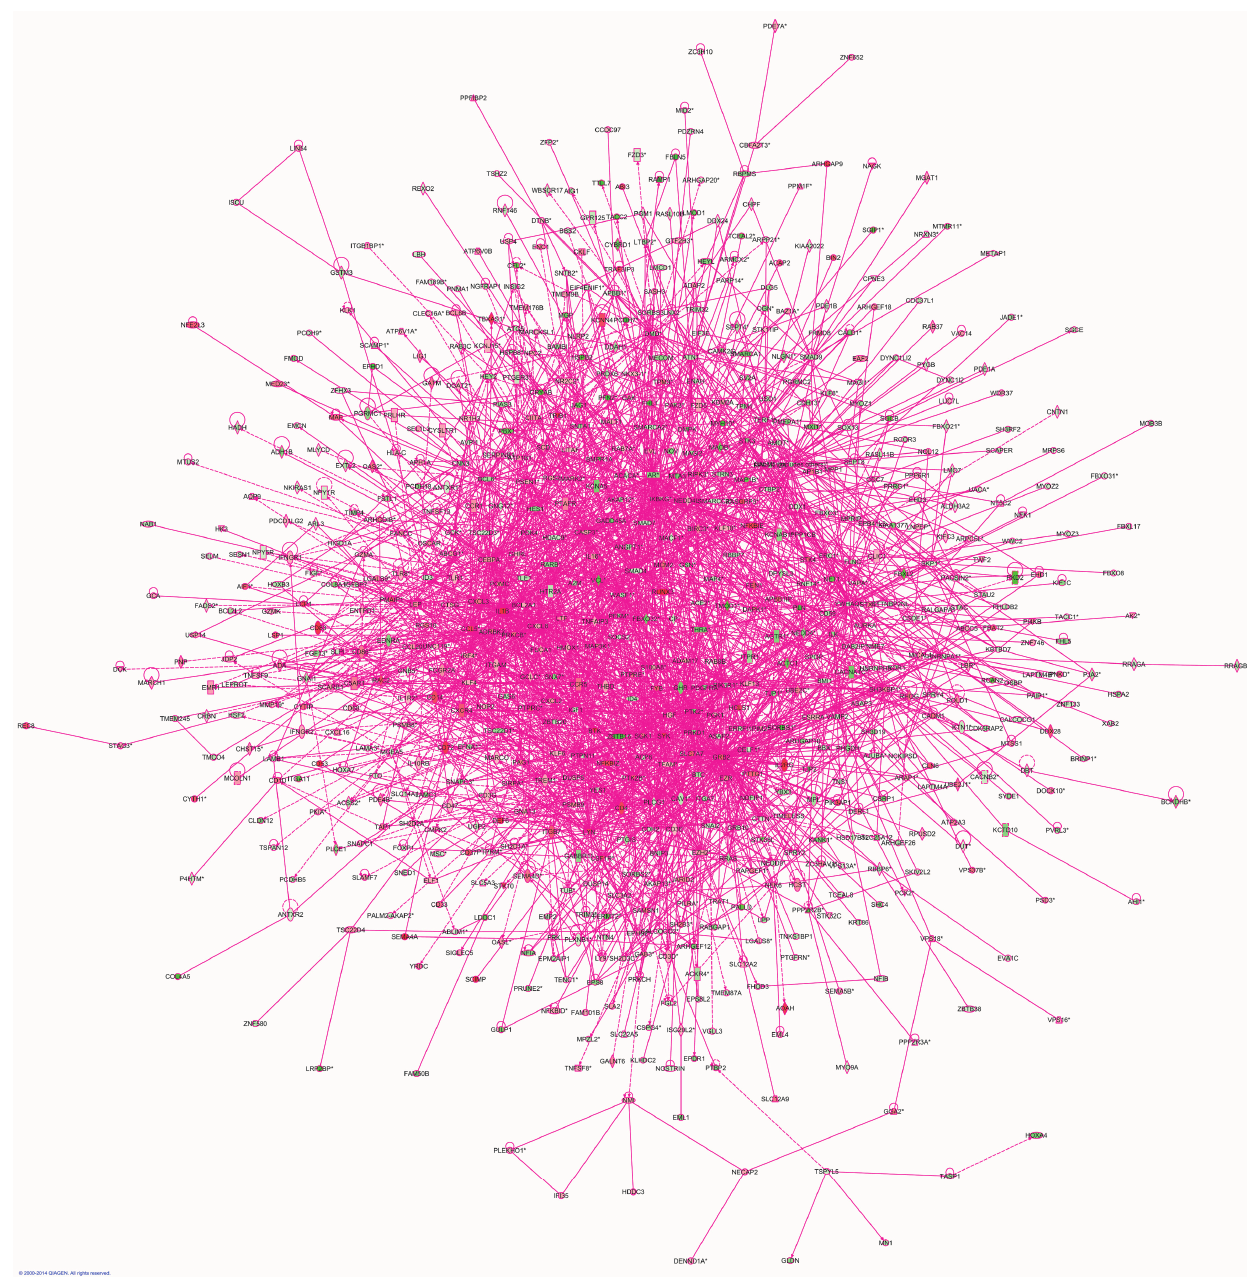
Figure 6. Network of interactions of the transcription factor target genes. Qiagen’s Ingenuity Pathway Analysis ® tool was used to analyze the genes with chers based on the current study using ChIP-chip. This analysis yielded 25 networks, which were then merged. Green molecules showed decreased and red increased mRNA expression in AAA in our previous microarray expression analysis [7]. Molecules are represented as nodes, and the biological relationship between two nodes is represented as a line. Solid lines represent direct interactions and dashed lines indirect interactions. All lines are supported by at least one literature citation or from canonical information stored in the Ingenuity Pathways Knowledge Base. Nodes are displayed using various shapes that represent the functional class of the gene product. See Table S9 for listing of